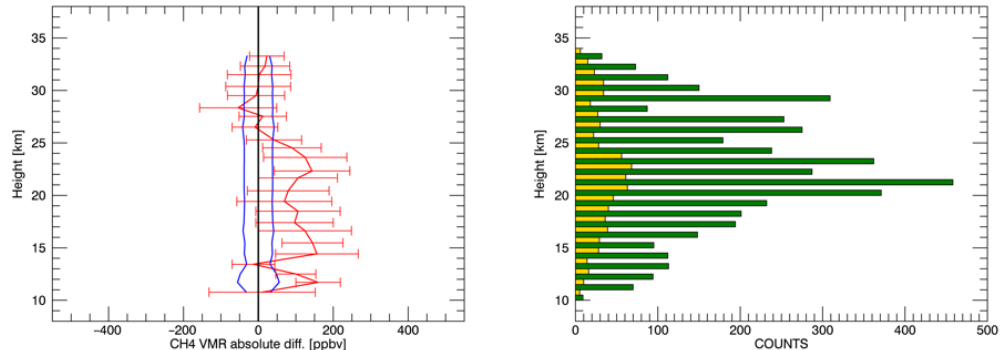
Figure 3. Left panel: CH 4 validation based on all cryosampler (BONBON) flights considered in this study. Red line: interpolated mean difference between MIPAS-E and cryosampler mixing ratio values. Red error bars: mean standard deviation of the difference between MIPAS-E and cryosampler mixing ratio value interpolated to the respective altitude. Blue line: interpolated mean error for CH 4 mixing ratio values from MIPAS-E. Right panel: corresponding database of MIPAS-E. Green bars: total no. of matches. Yellow bars: no. of independent scans which are matched.